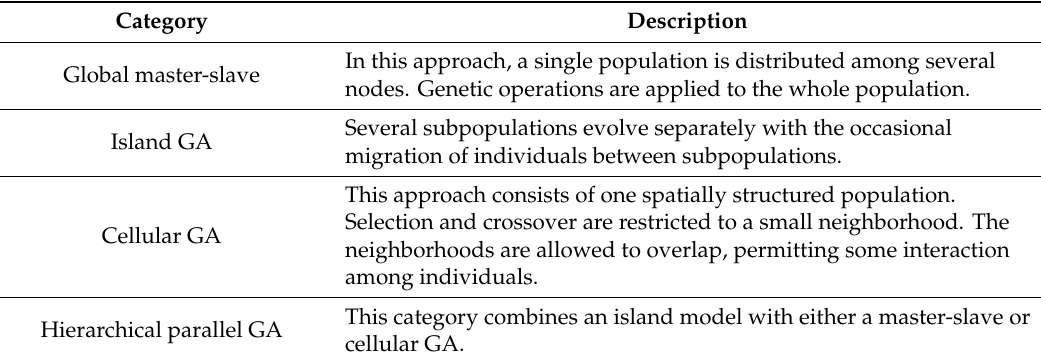
Table 2. Categories of parallel genetic algorithms [47].